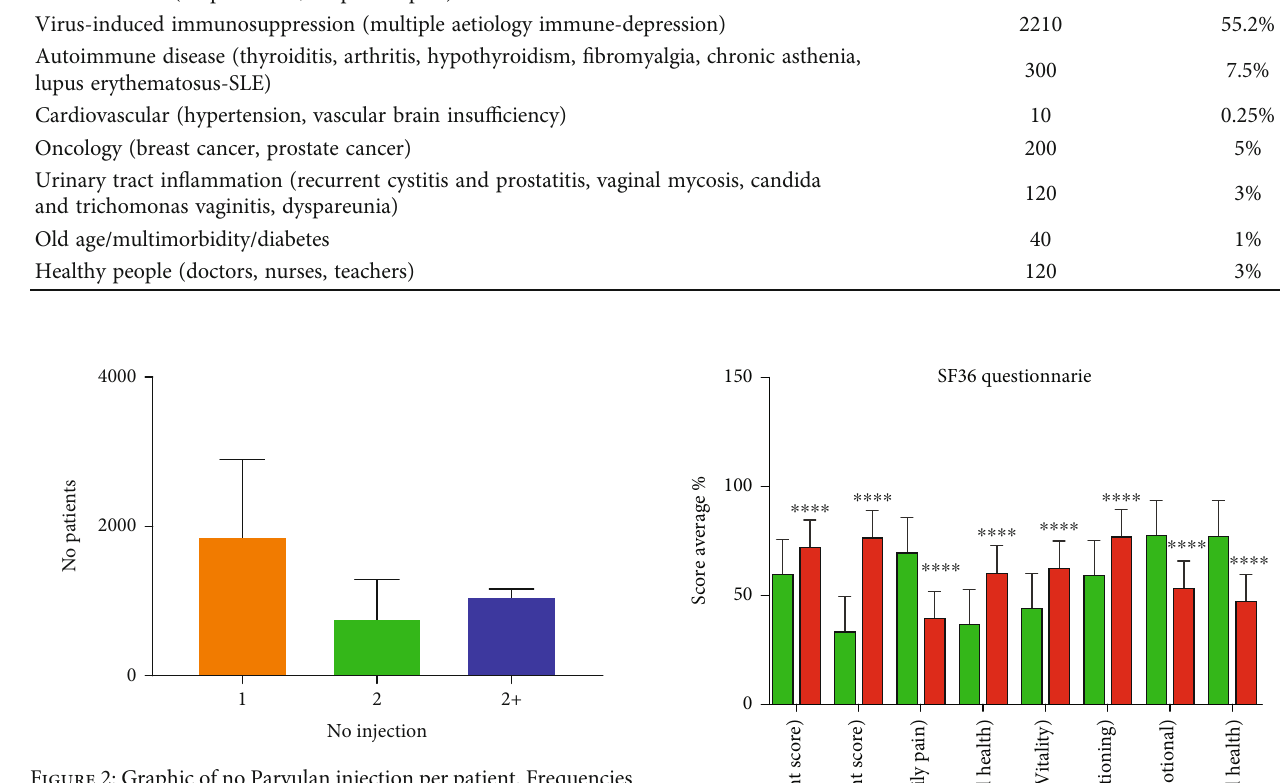
Figure 2: Graphic of no Parvulan injection per patient. Frequencies of Parvulan injection (once only, or twice or more) in enrolled patients ( n = 4000 ), based on medical judgement and disease severity.